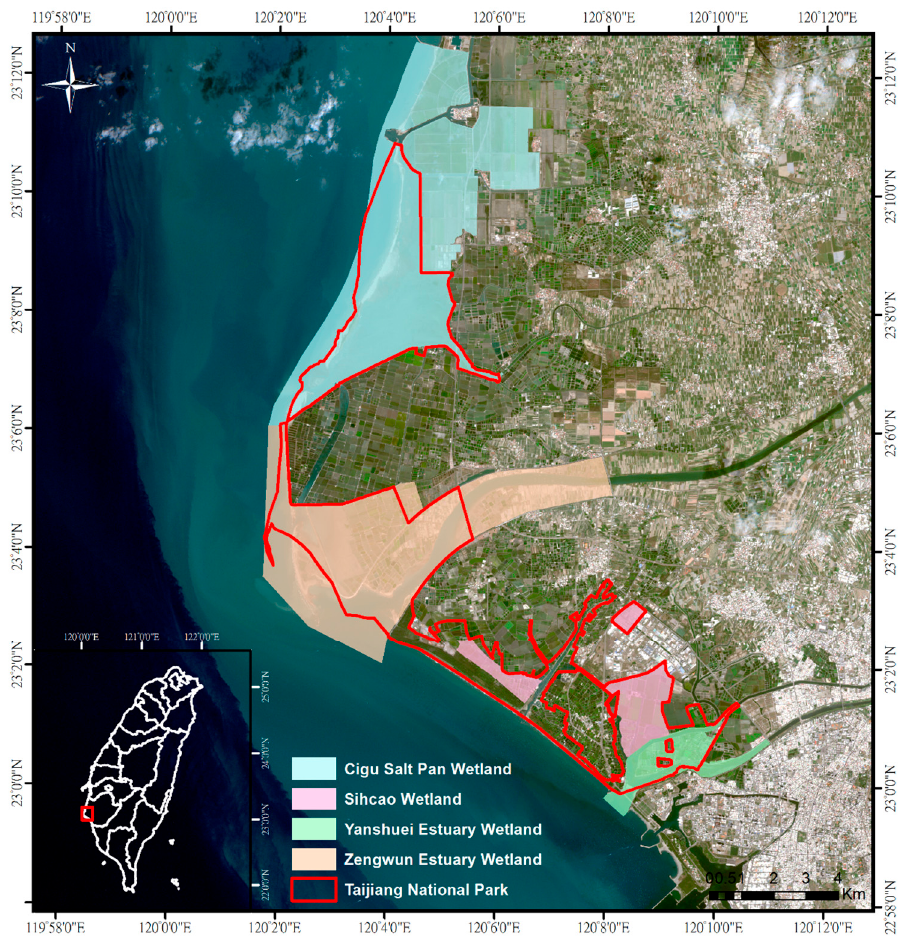
Figure 1. The geographical location of Taijiang National Park (TNP) (delineated by red lines) and the four main wetland areas: Zengwen Estuary Wetland, Sicao Wetland, Qigu Salt Pan Wetland and Yanshui Estuary Wetland. Our study area is located in the main part of TNP, covering Yanshui Estuary Wetland and Sicao Wetland. The true color image (10 m resolution) was acquired by Sentinel-2 on 15 February 2018.